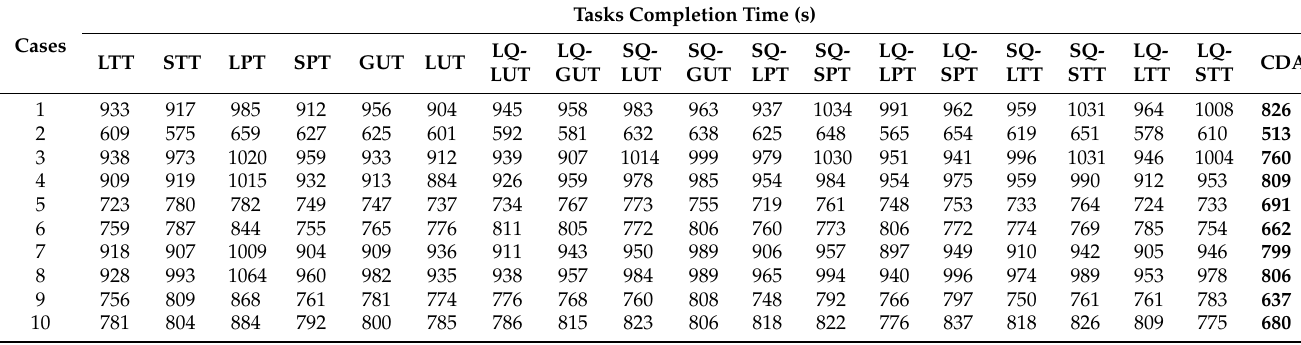
Table A1. Tasks completion time of CDA algorithm and assignment rules under different cases.